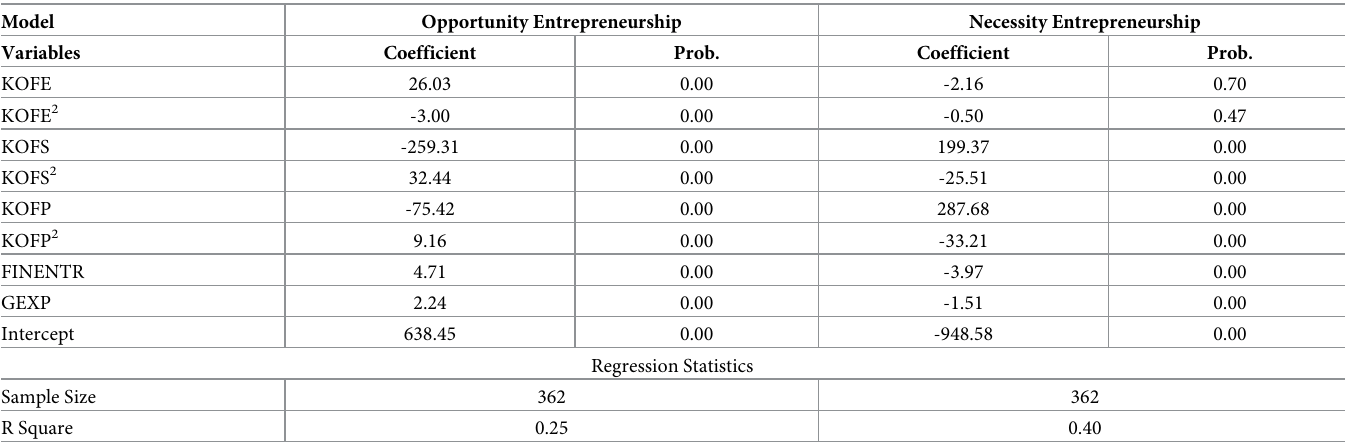
Table 3. Regression estimates using